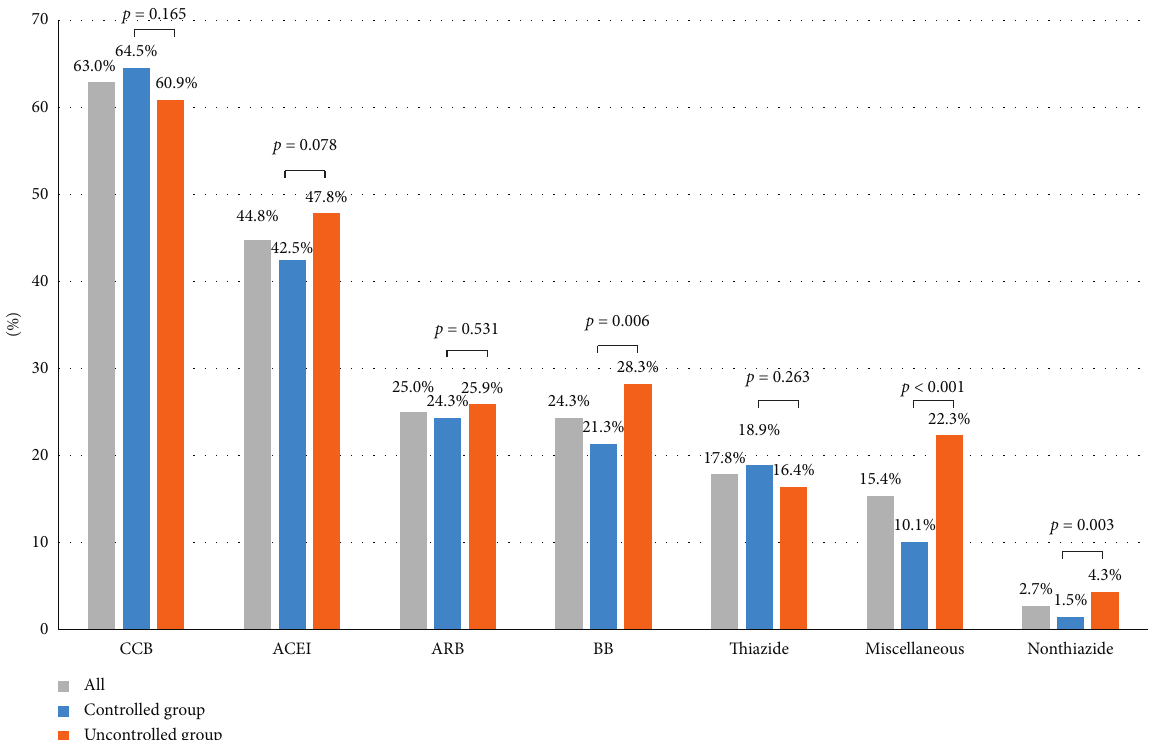
Figure 2: Prescribing frequency of each antihypertensive drug class at one year of follow-up. DM � diabetes mellitus; CCB � calcium channel blocker; ACEI � angiotensin-converting enzyme inhibitor; ARB � angiotensin receptor blocker; BB � beta-adrenergic blocker; Thiazide � thiazide-type diuretic (hydrochlorothiazide, chlorthalidone); nonthiazide � nonthiazide diuretic (amiloride, spironolactone, furosemide); miscellaneous � alpha-adrenergic blocker, hydralazine, clonidine, and